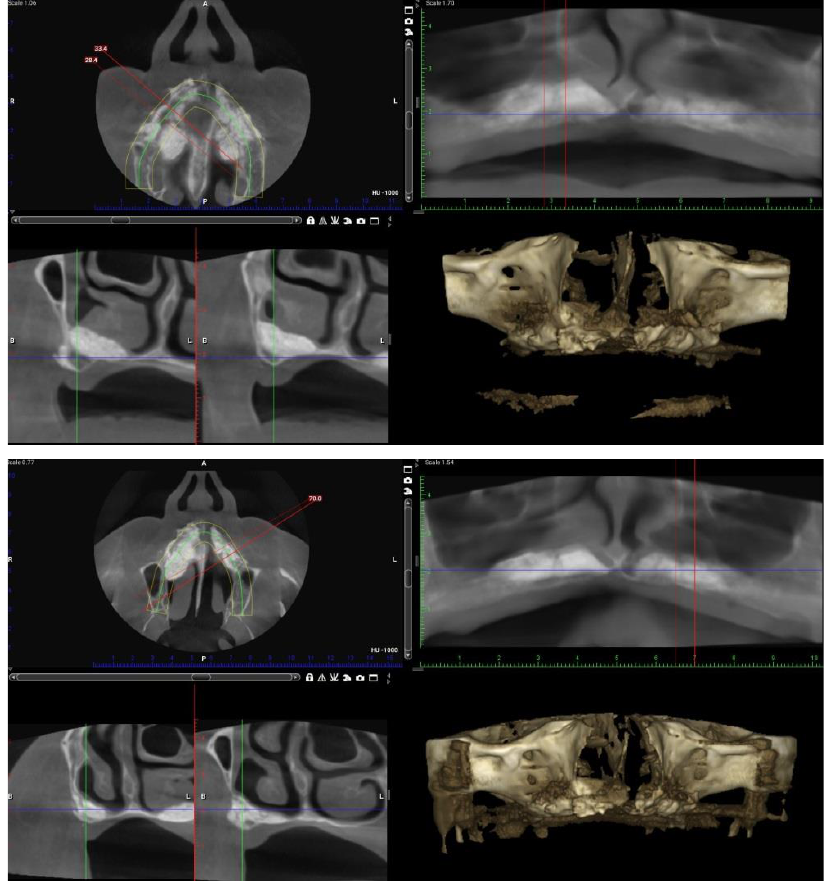
Figure 4. Postoperative control CBCT scan. A – anterior, P – posterior, R – right, L – left or lingual, B – buccal.